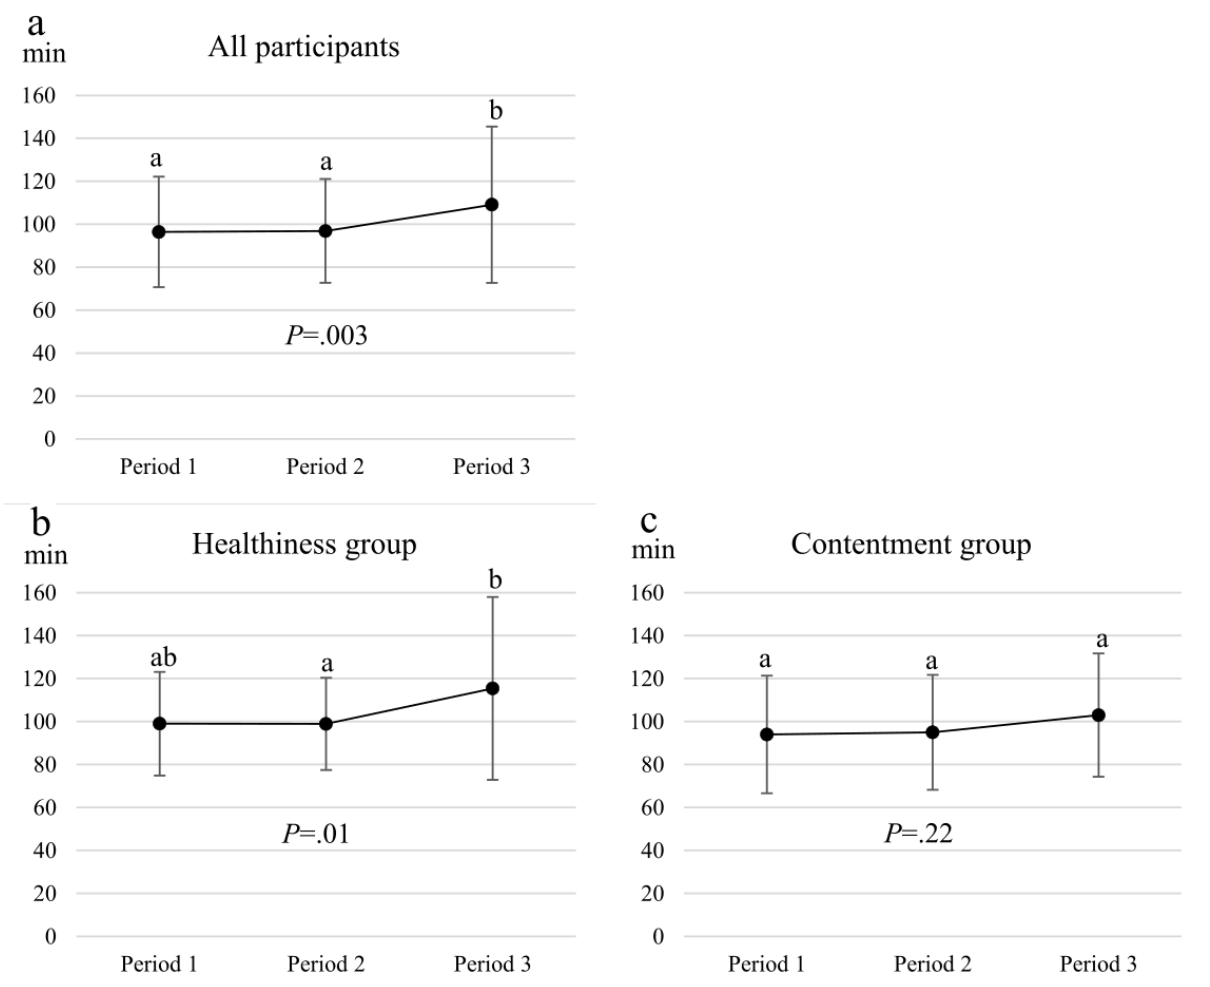
Figure 3. Average intervals between eating occasions (Button presses) (mean ± SD) in the three periods (Period 1 = days 1-10, Period 2 = days 11-20, Period 3 = days 21-30) in a) all participants (n=59) and members of b) Healthiness group (n=29) and c) Contentment group (n=30). Different superscript letters indicate a statistically significant difference (P ≤ .05) between study